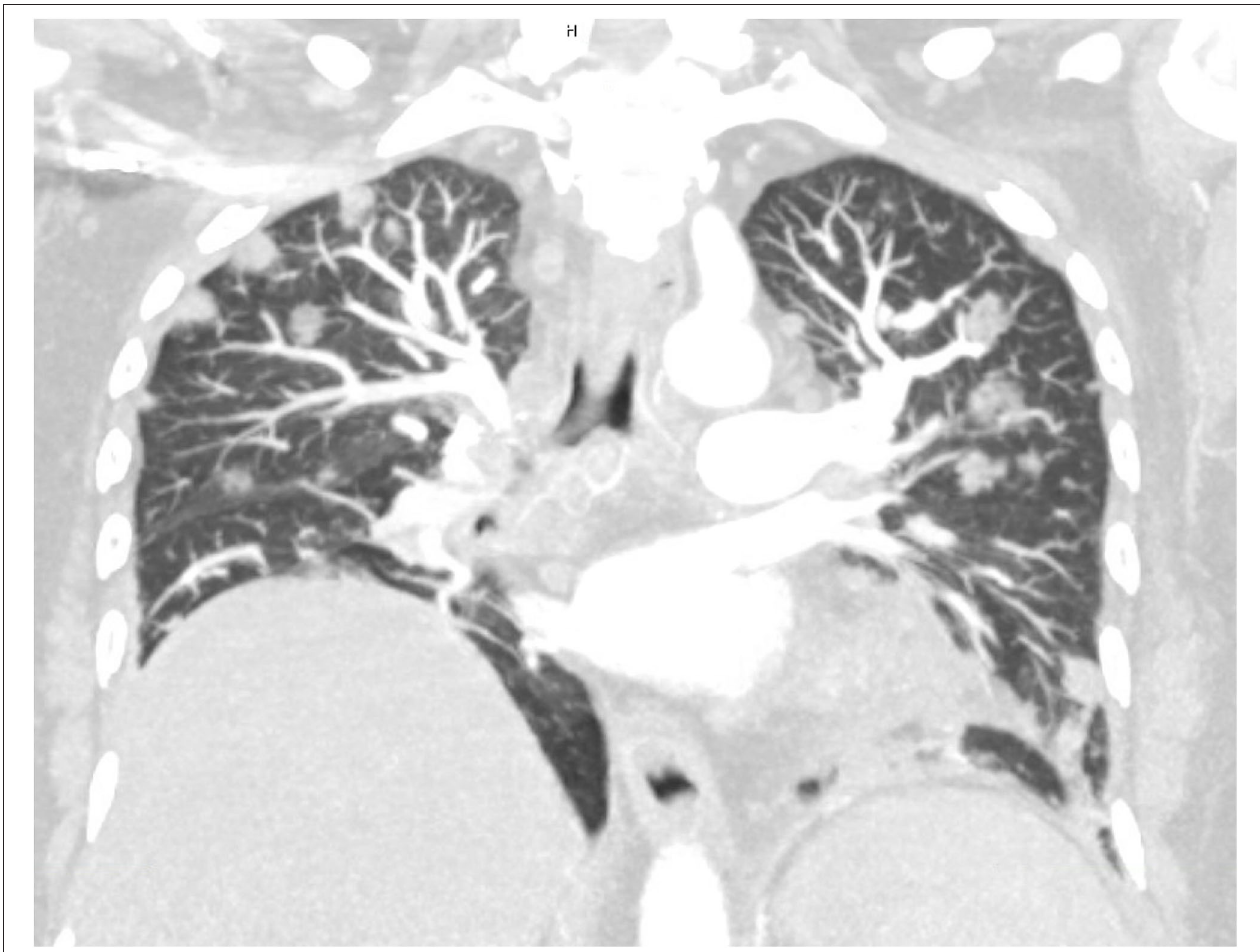
FIGURE 1 | Maximal intensity projection (MIP) of multi-planar reconstruction computed tomographic angiography at admission day. Multiple septic embolic lesions appearing as nodules are present predominantly in the subpleural as well as peribronchovascular area, while close topographic proximity to the branching pulmonary arteries is